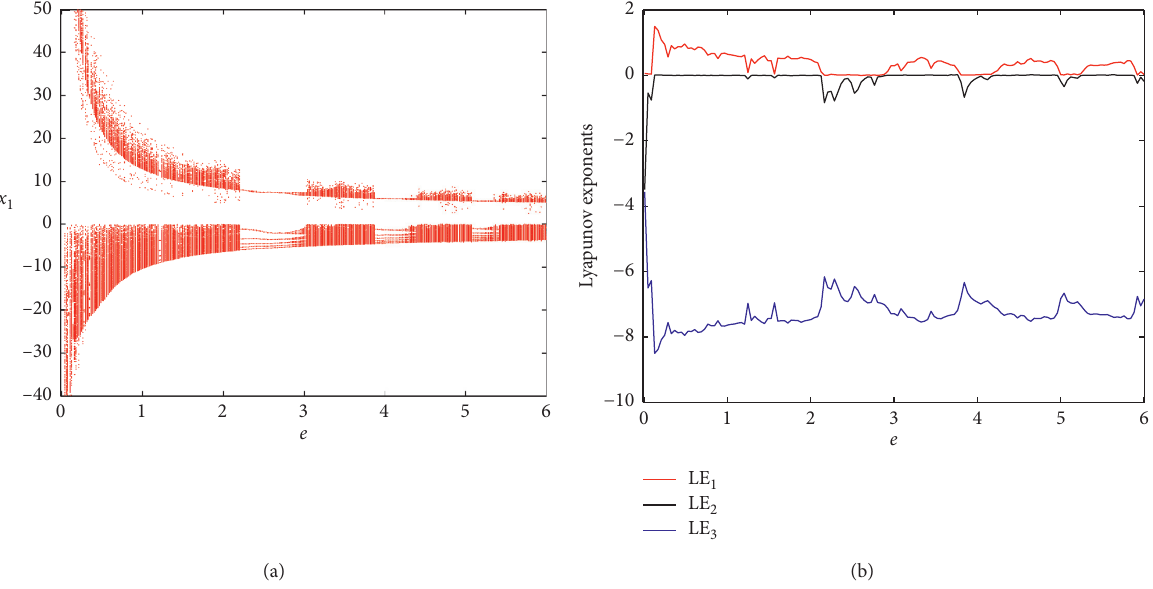
Figure 8: (a) Bifurcation diagram and (b) finite time Lyapunov exponent spectrum versus e .